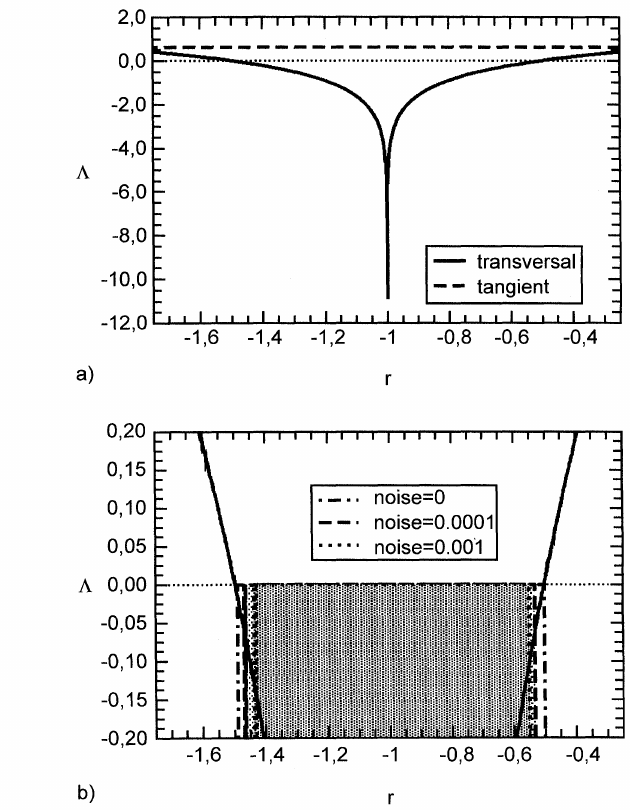
FIGURE 7 Dependence of the normal Lyapunov exponent for antiphase chaotic attractor on the controlling parameter (a) at a 3.8, -y =0.04. Dashed line denotes the values of the tangent Lyapunov exponent. In the (b) this dependence is presented in larger scale with regions of the antiphase con- trolled